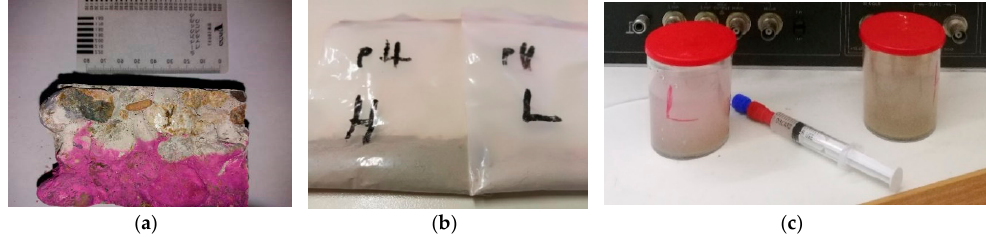
Figure 3. Studied concrete samples in ( a ) solid, ( b ) powder, and ( c ) suspension form.